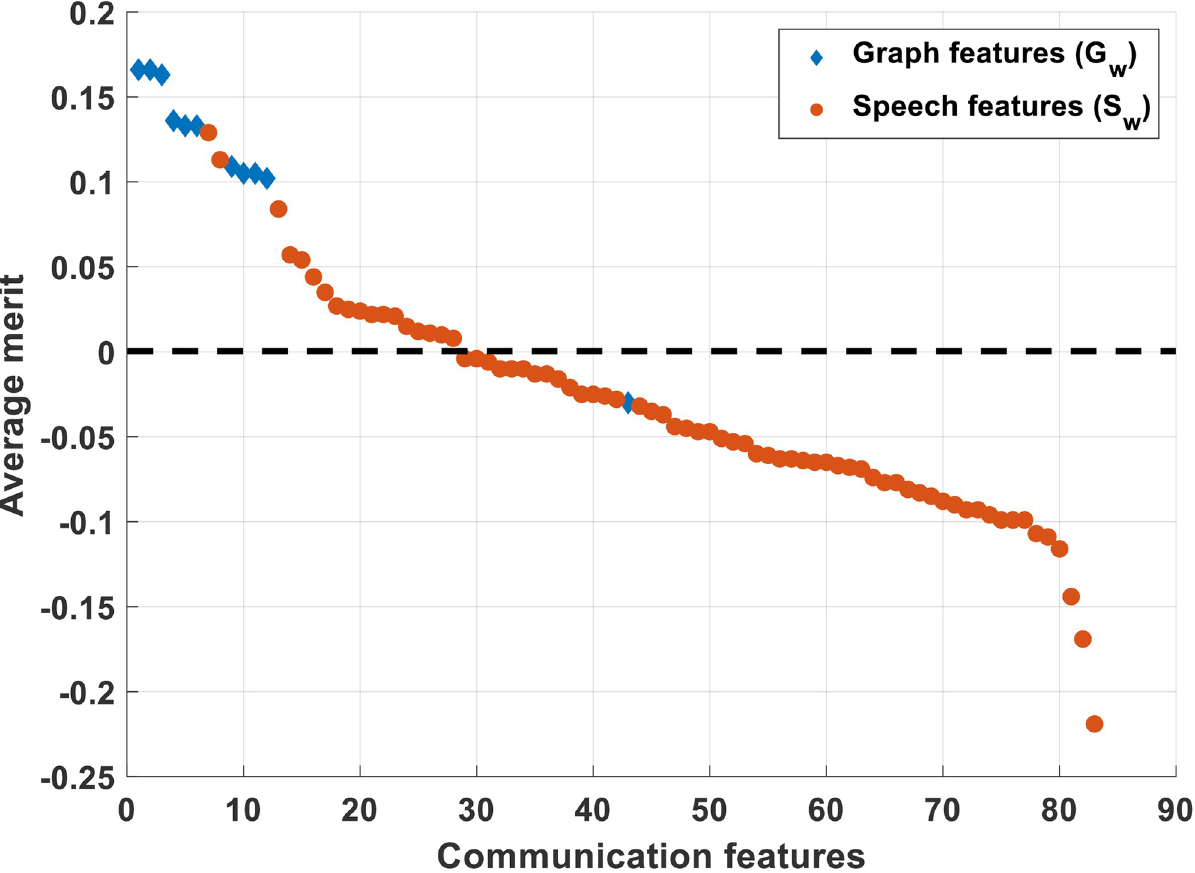
Fig 4. Correlation coefficients for each selected communication